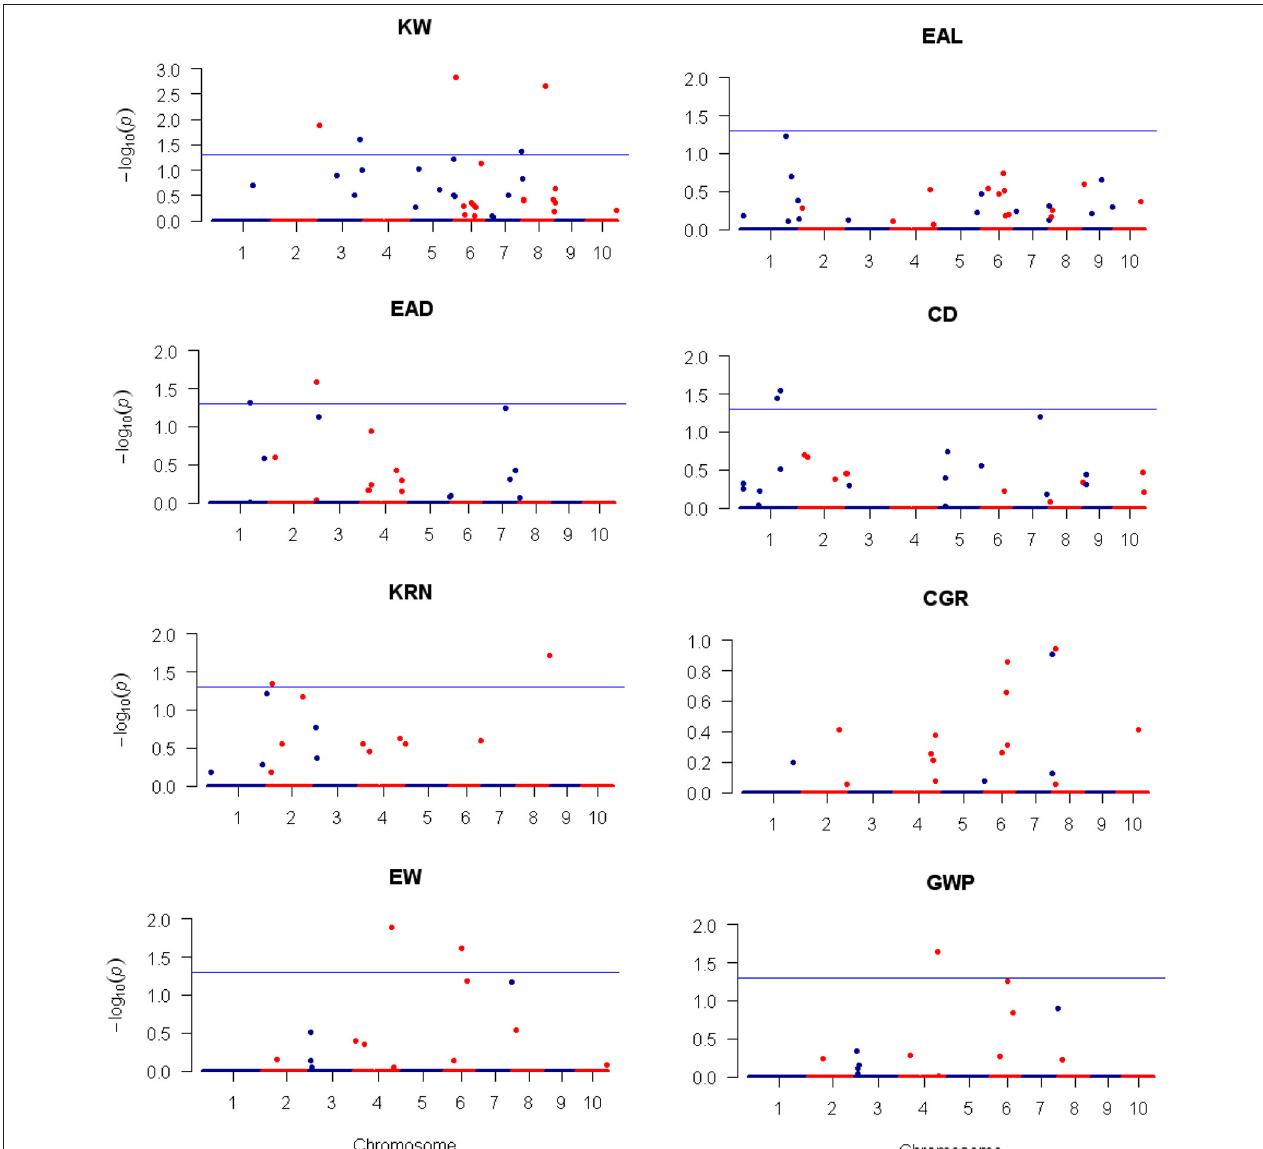
FIGURE 5 | Plots of the additive effect test statistic − Log10( p ) against genome location for eight traits of maize using the LASSO method. The horizontal blue line is the critical value of the test statistic at the nominal level of − Log10(0.05) = 1.3. Note that LASSO is a multiple marker model and no adjustment for the critical value of test statistic is